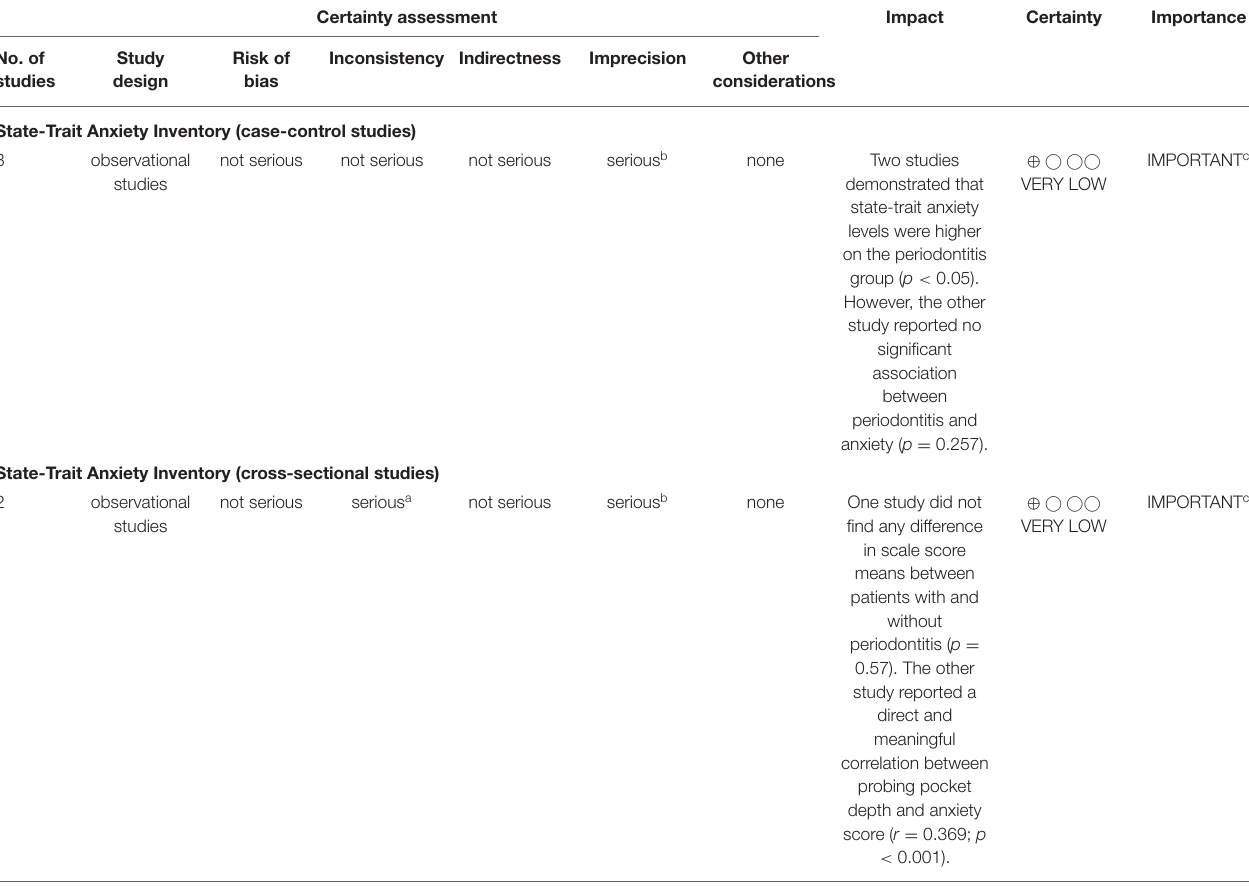
TABLE 3 | Narrative evidence profile according to the Grading of Recommendation, Assessment, Development, and Evaluation (GRADE)